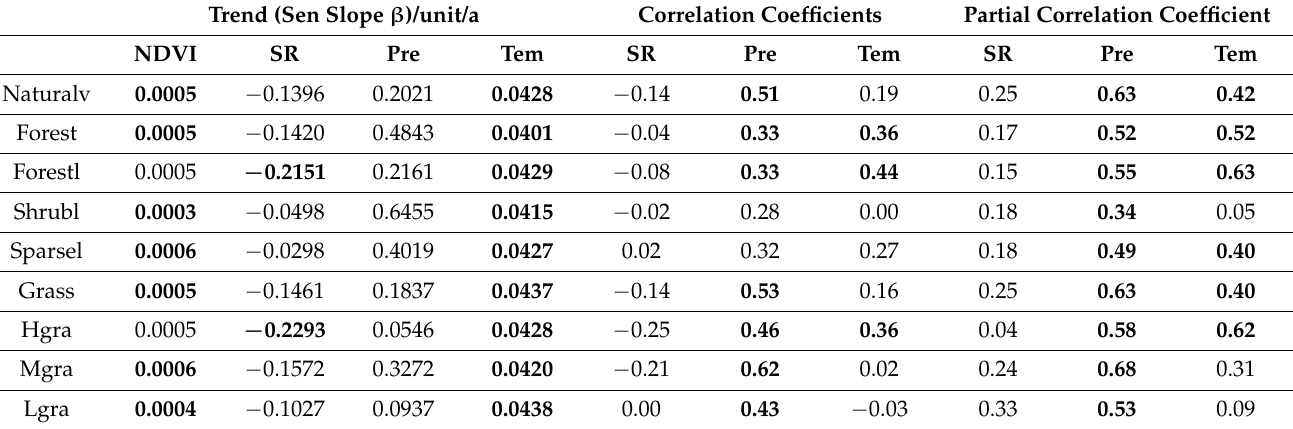
Figure 3. The means ( a , c , e , g ) and trends ( b , d , f , h ) in climate variables and Normalized Difference Vegetation Index (NDVI) during the growing season in the arid region of northwestern China (PCT is the abbreviation of percent; SD, significantly decreasing trend; ISD, non-significant decreasing trend; ISI, non-significant increasing trend; SI, significantly increasing trend). The visualized colors in the left-hand graphs refer to the mean climate and NDVI values, while those in the right-hand graphs refer to the trends in climate and NDVI. Table 2. Regional changes (Sen slope β ) and correlations between the Normalized Difference Veg- etation Index (NDVI) and climate variables in the arid region of northwestern China (SR: solar radiation; Pre: precipitation; Tem: temperature; significant trends and correlation coefficients at a 0.05 significance level were indicated in